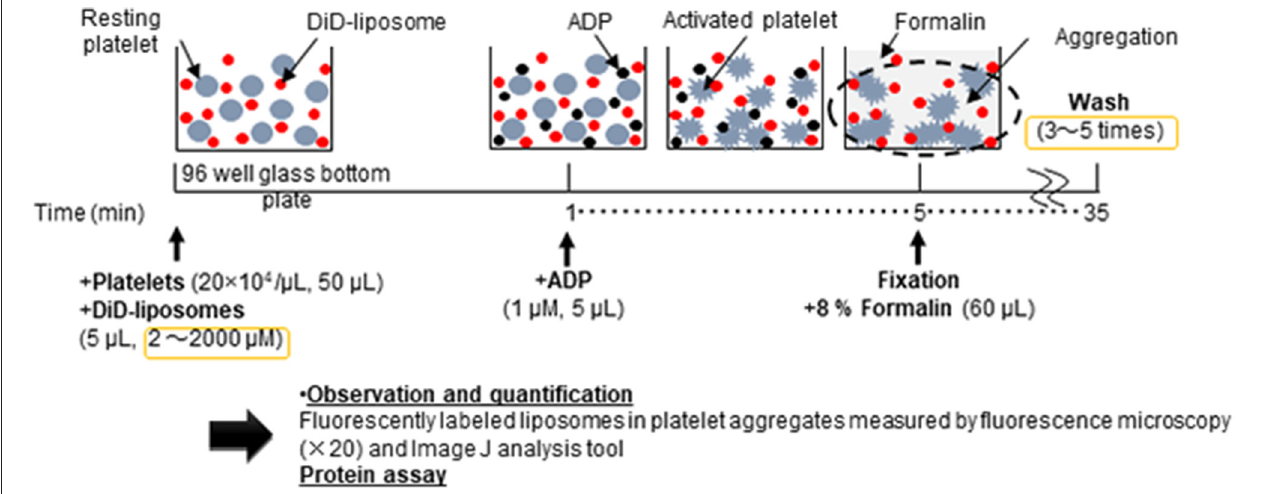
FIGURE 1 | Schematic flow diagram of the in vitro aggregation assay of nanosized platelet substitutes with activated platelets by fluorescence microscopy and image analysis.